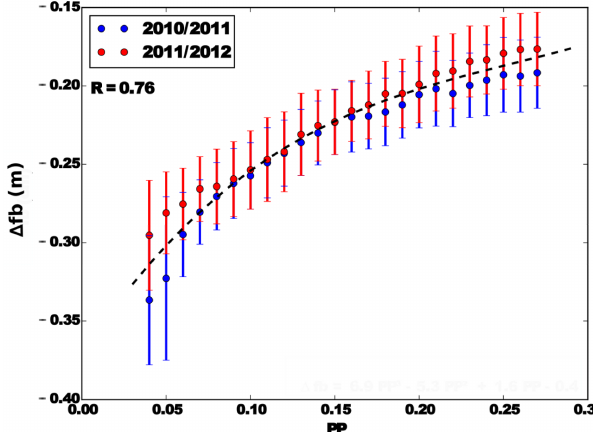
Figure 5. Relation between the monthly freeboard difference be- tween Envisat and CryoSat-2 ( (cid:49) fb) and the monthly Envisat pulse peakiness (PP) shown for winter 2010/2011 (blue) and 2011/2012 (red). The error bars show the corresponding standard devia- tion for each value and the dark tilted line represents the linear fit of all monthly observations (November 2010–April 2011 and November 2011–March 2012). The fitting equation is given by (cid:49) fb = 6.9.PP 3 + 5.3PP 2 + 1.6.PP −